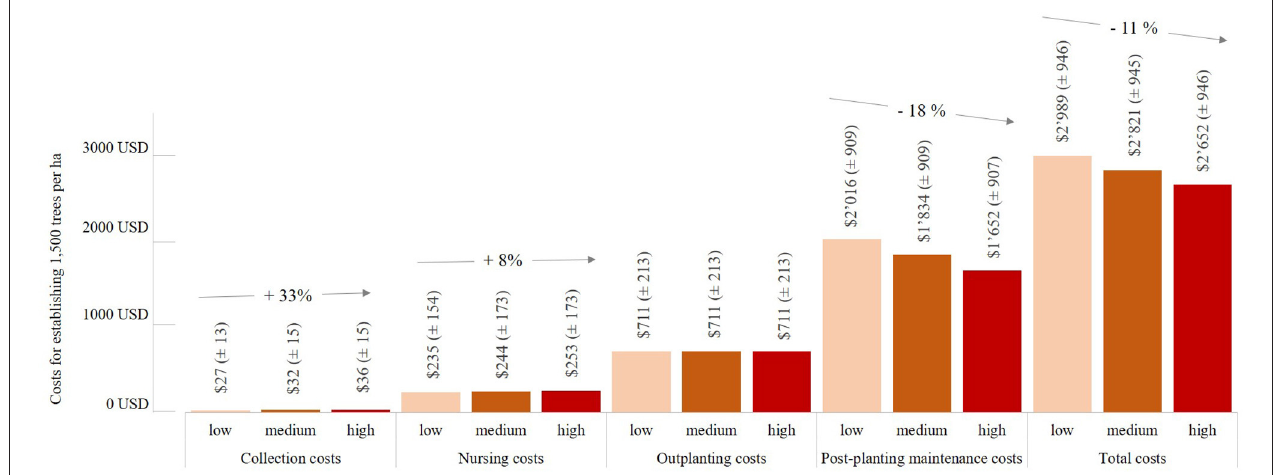
FIGURE 3 | Effects of different categories of genetic quality (low, medium, and high) on costs (approximate mean values and the associated standard deviations) of planting stock raised in a nursery from seed on sites with a vegetation consisting predominantly of grass (former pasture sites). In this scenario, the level of impact of all other cost drivers was